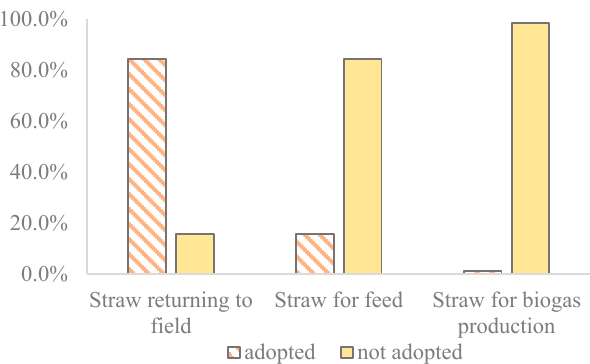
Figure 3. Utilization of farmers’ straw resources.